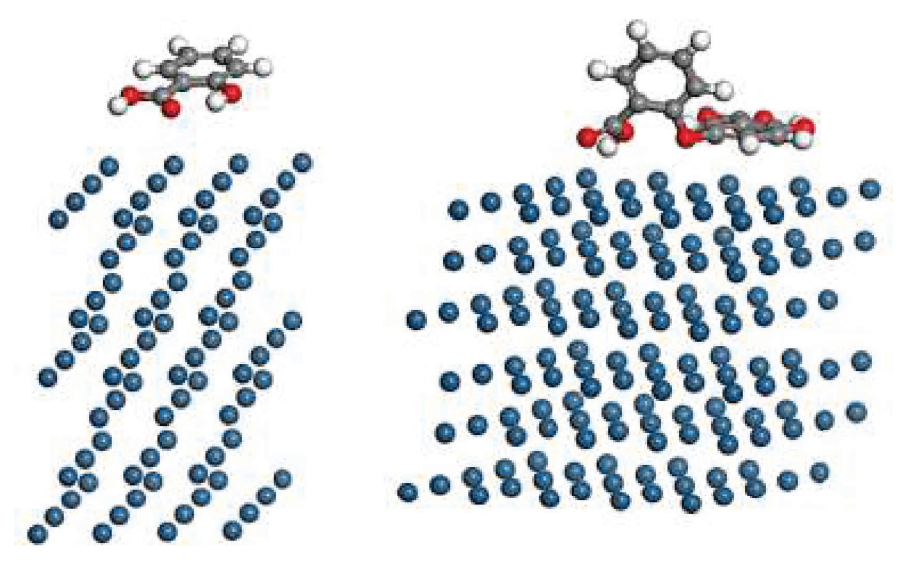
Figure 18: Adsorption of the monomer SA and PSA on the mild steel